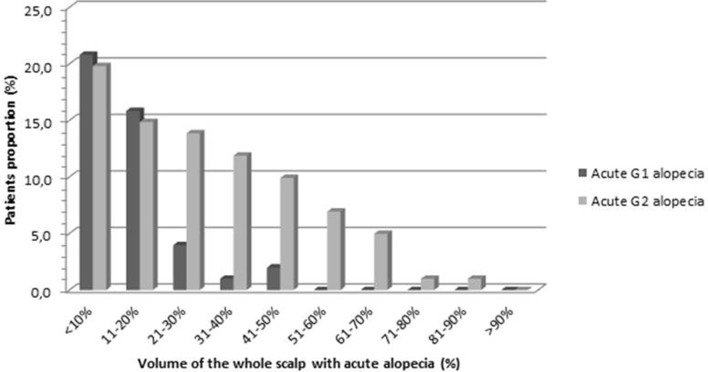
Percentage of the volume of the scalp with G1 and G2 alopecia at the end of radiotherapy.